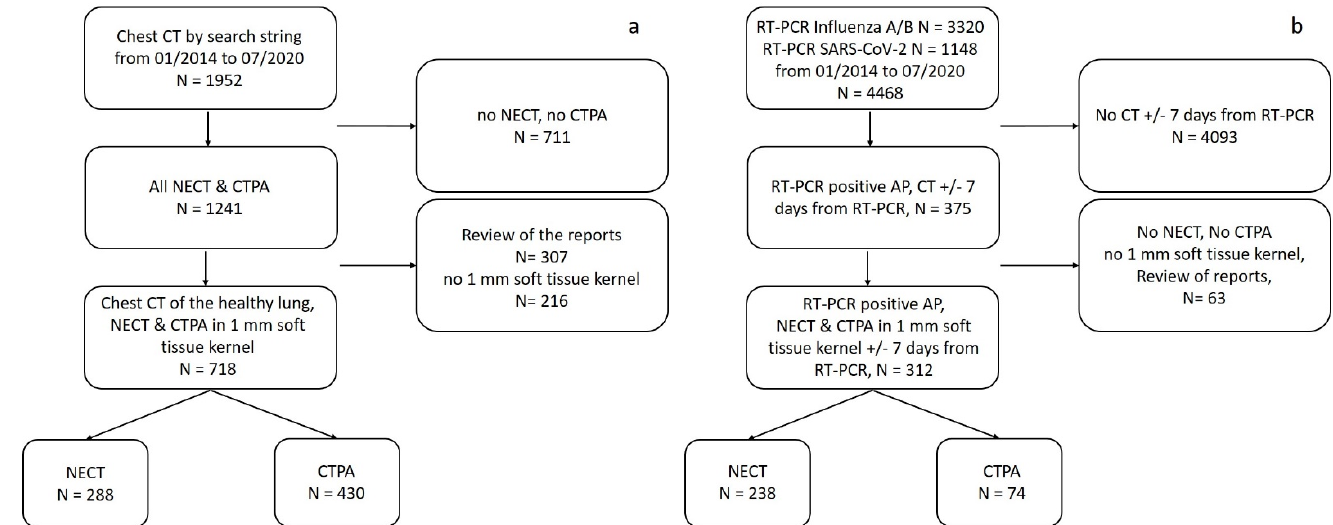
Figure 1. Study selection flow diagrams for ( a ) healthy lung and ( b ) AP groups. Abbreviations: NECT = non-enhanced computed tomography. CTPA = computed tomography pulmonary angiogram. AP = atypical Pneumonia.